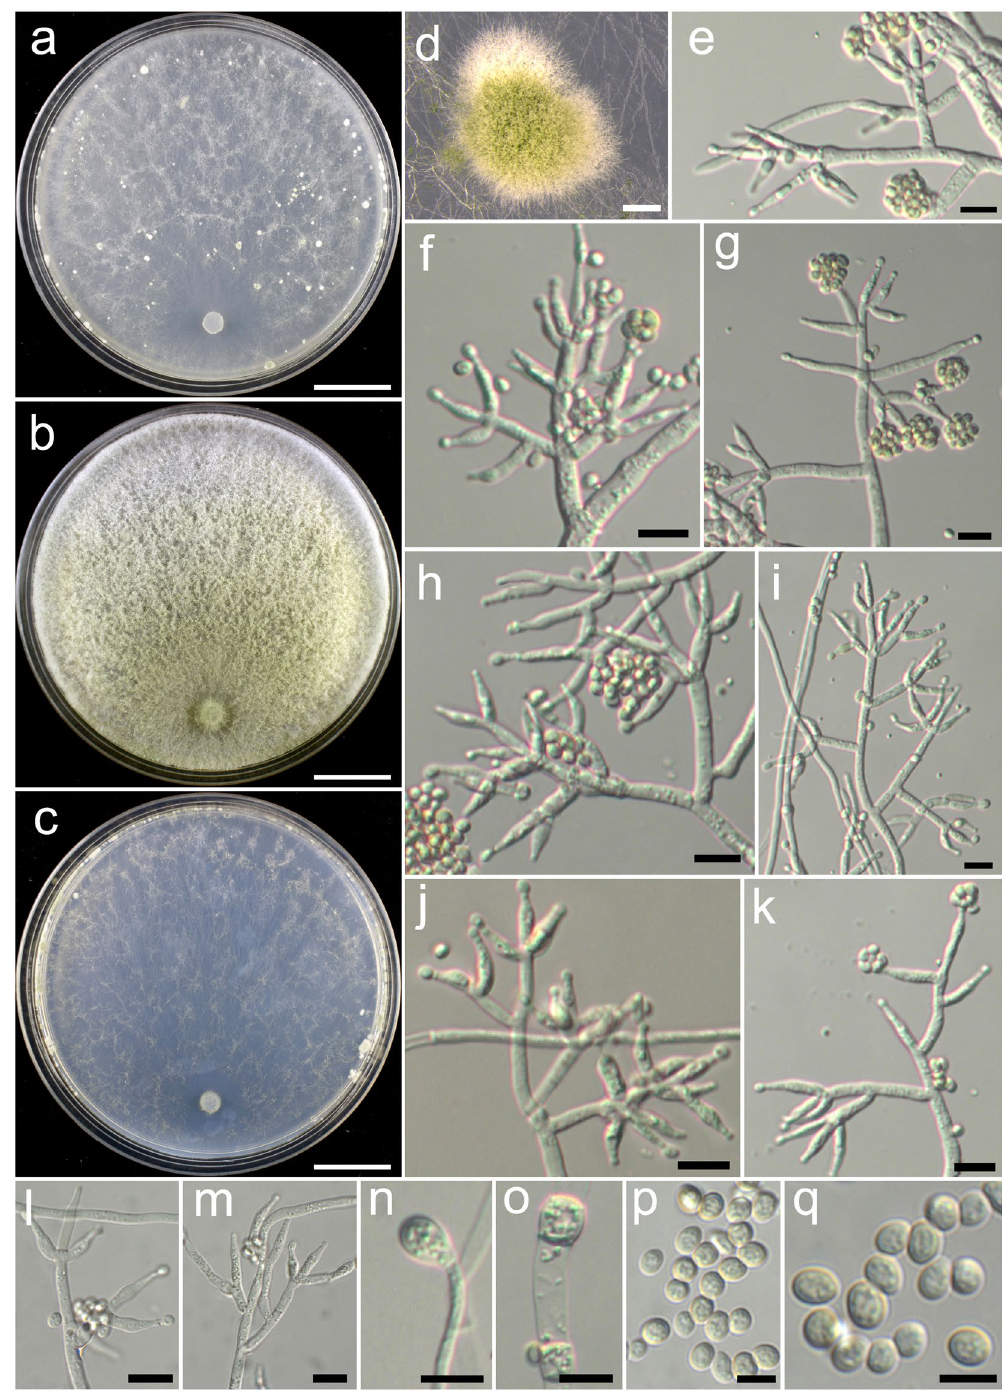
Figure 17. Trichoderma linzhiense (HMAS 248846). ( a – c ) Cultures at 25 °C, 7 d (a. on CMD; b. on PDA; c. on SNA); ( d ) Conidial pustules (CMD, 7 d); ( e – m ) Conidiophores and phialides (PDA, 5 d); ( n – o ) Chlamydospores (CMD, 5 d); ( p – q ) Conidia (PDA, 5 d). Bars: a–c = 20 mm. d = 400 μ m. e–o = 10 μ m. p–q = 5 μ